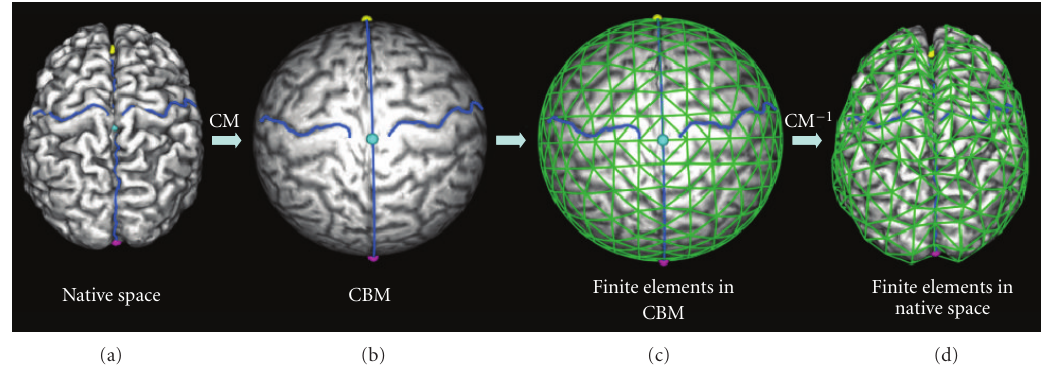
Figure 2: Landmark-constrained conformal surface mapping of the cortex onto a sphere and construction of finite surface elements. (a) Cortical surface of a brain with defined landmarks showing the bilateral central sulci. (b) Landmark-constrained conformal mapping (CM) of the cortical mantel to the surface of a sphere. Constraints are enforced during conformal mapping so that the midplane is mapped to the main circle of the unit sphere, and landmarks (e.g., central sulcus) are mapped to the same spatial location. (c) Geometric parcellation of the unit sphere into 512 surface finite elements. (d) Location of the same surface finite elements after reverse conformal mapping (CM − 1 ) into the subject’s native